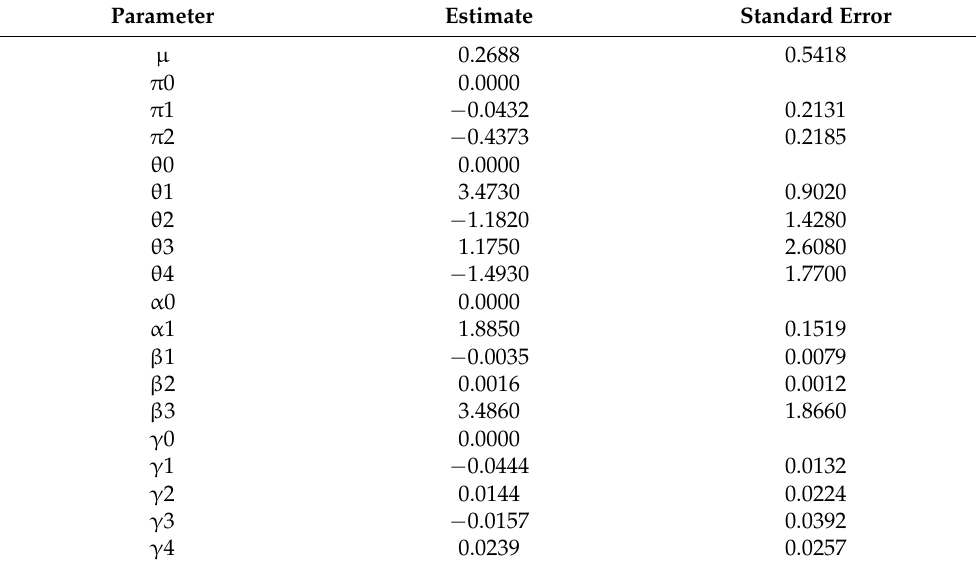
Table 7. Summary table of the decomposition of the variability